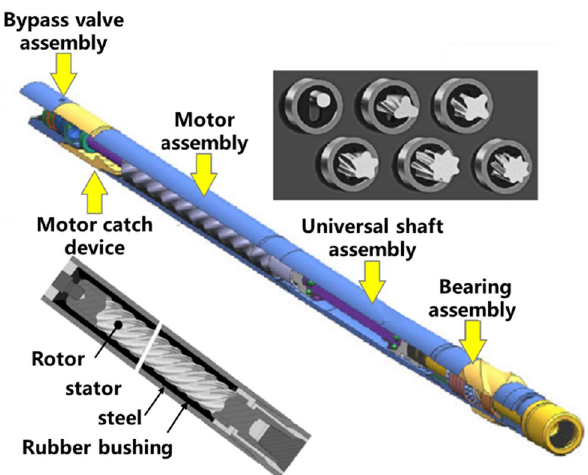
Fig. 16 Schematic of a typical PDM tool (Ma et al.